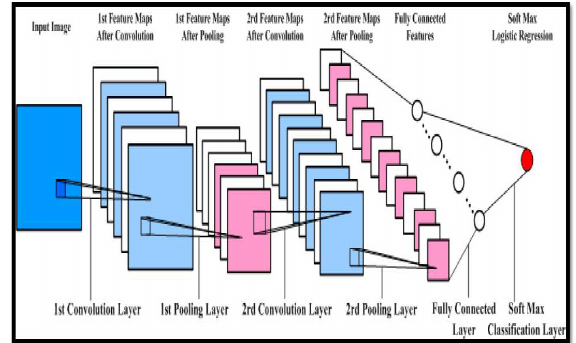
Figure 6. Blocks of Inception